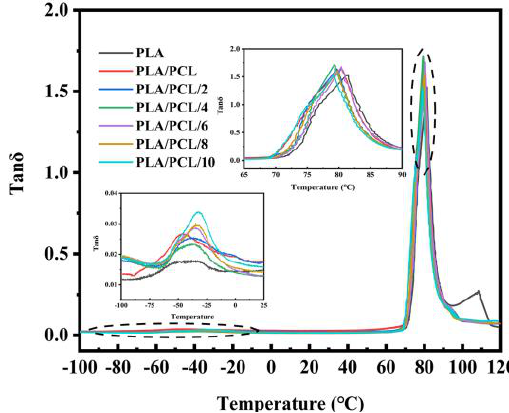
Figure 4. Plots of the loss factor (tan δ ) against the temperature for the neat PLA, PLA / PCL and PLA / PCL / EMA-GMA blends. Table 1. DMA results of the PLA, PLA / PCL and PLA / PCL / EMA-GMA blends.